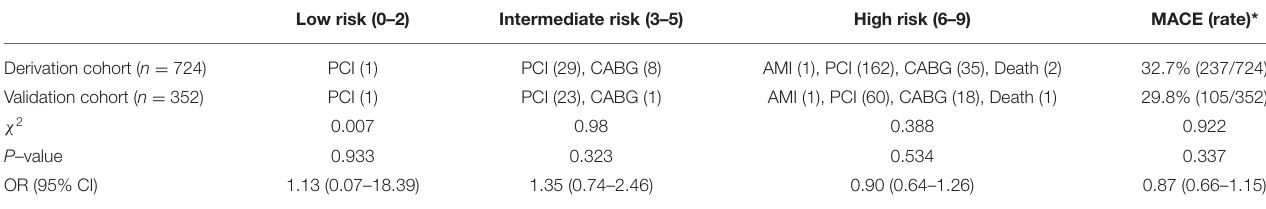
TABLE 4 | Classifications of chest pain patients in the derivation cohort and validation